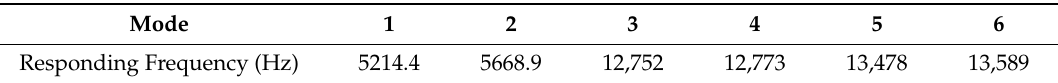
Table 5. Resonance